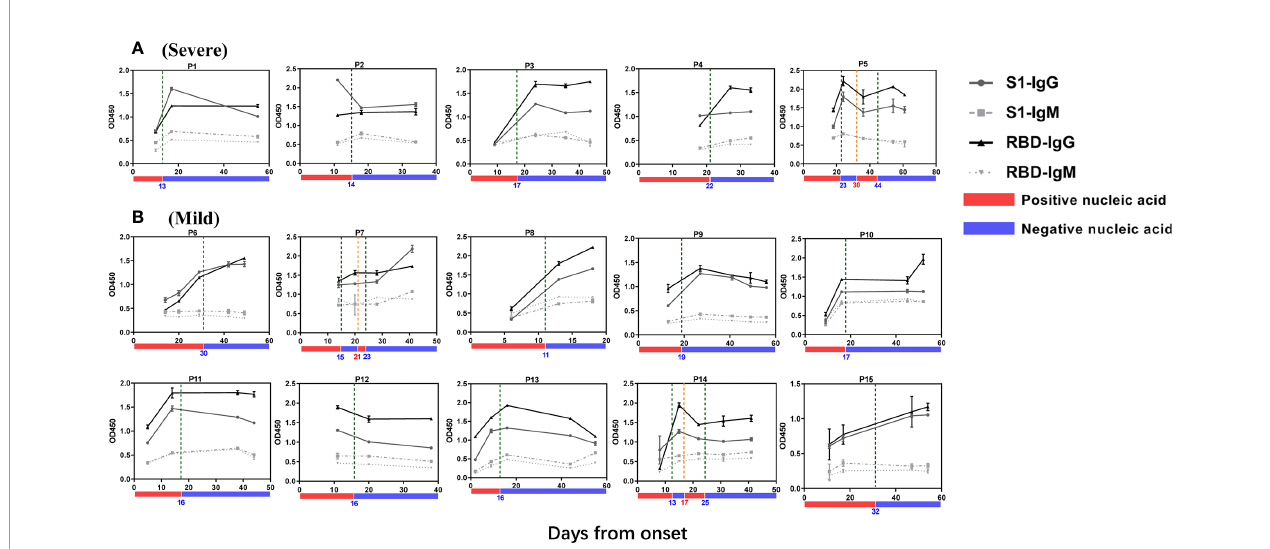
FIGURE 1 | SARS-CoV-2-speci fi c Antibodies Increases During Disease Progression. Plasma were collected at different time points after syndrome onset. The titers of IgG or IgM antibody binding to S1 protein or RBD in fi ve COVID-19 patient plasma with severe symptom (A) or ten patients with mild symptoms (B) are shown. The green dotted line represents the time point when the patient ’ s nucleic acid turns negative while the orange dotted line represents the time point when the patient ’ s nucleic acid turns positive. The red process bar indicates that the patient ’ s nucleic acid is positive, and the blue indicate a negative